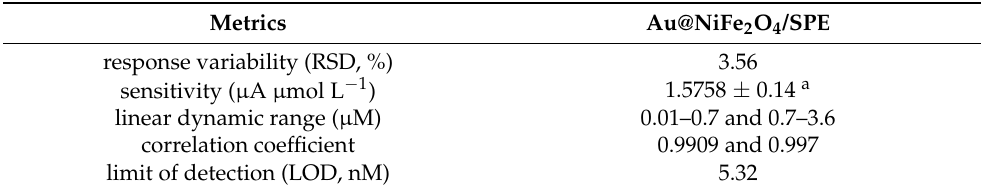
Figure 6. ( A ); Differential pulse voltammograms of EPR with increasing concentrations at the Au@NiFe 2 O 4 /SPE, ( B ); the plot of EPR concentrations versus oxidation current peak the Au@NiFe 2 O 4 /SPE in the concentration range of 0.01–3.6 µM. Table 2. Detection figures of merit for other methods for EPR reported in the literature. Table 1. Determination figures of merit for EPR at Au@NiFe 2 O 4 /SPE.